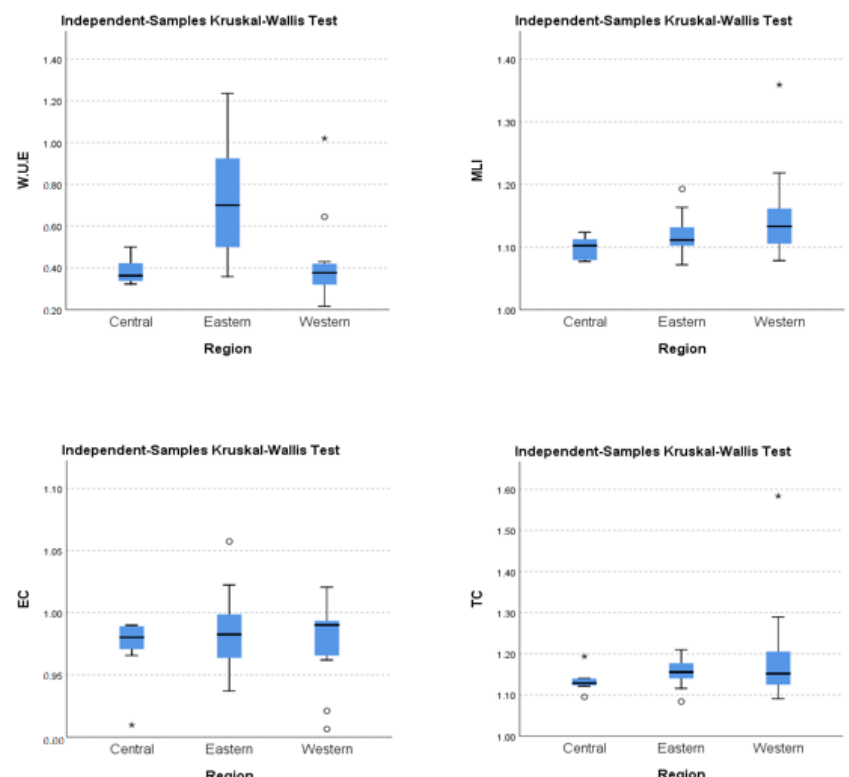
Figure 7. Distribution of average WUE, MLI, EC, and TC across the three regions of China.